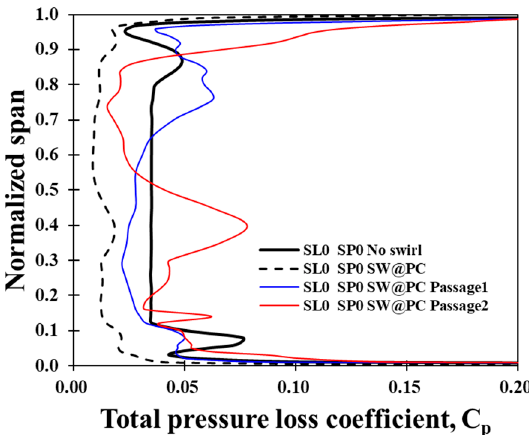
Figure 24. Comparison of circumferentially averaged total pressure loss coefficients for passage 1 and 2.